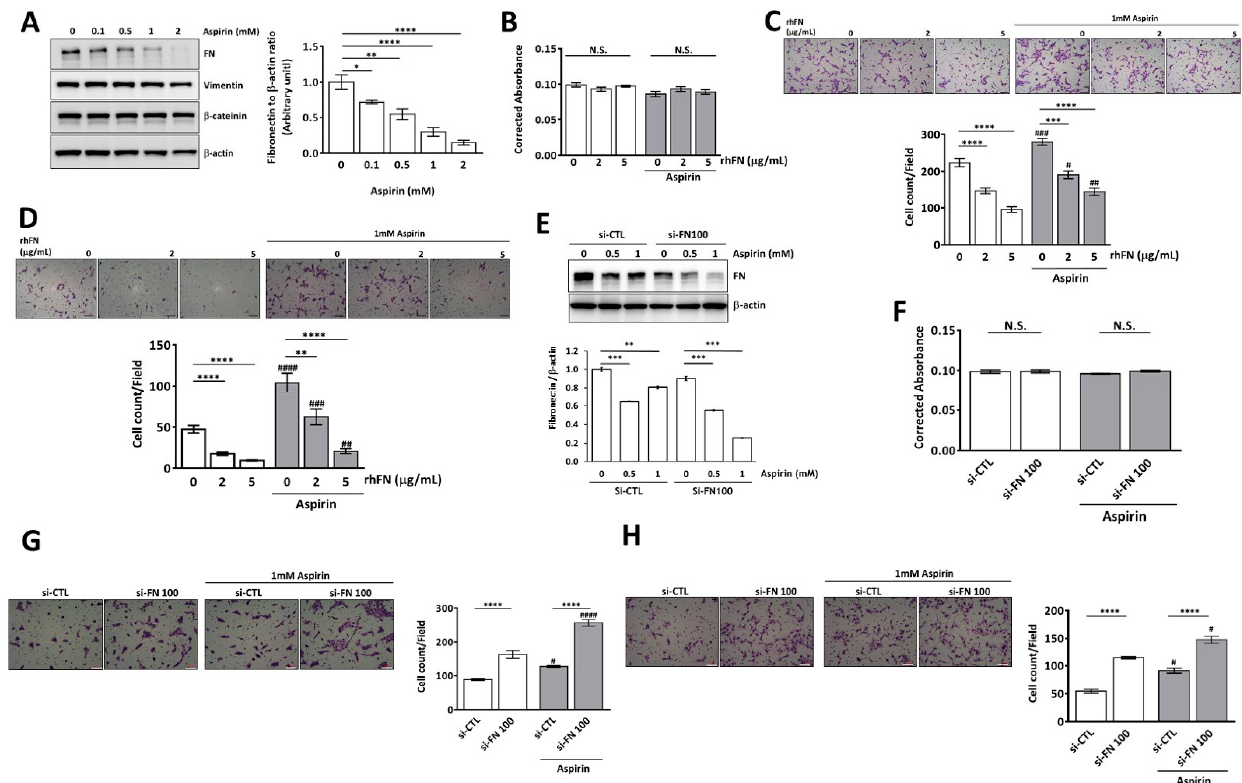
Figure 4. Aspirin inhibits fibronectin (FN) expression and reverses FN-mediated trophoblast migration and invasion in HTR-8/SVneo cells. ( A ) Different doses of aspirin (0, 0.1, 0.5, 1, and 2 mM) were used to treat HTR-8/SVneo cells for 24 h, and then cellular FN expression in the cell lysate was analyzed and quantified using Western blotting. ( B – D ) HTR-8/SVneo cells were treated with rhFN (5 μ g/mL) for 24 h and then aspirin (1 mM) for another 24 h, and the cells were then subjected to ( B ) cell viability, ( C ) cell migration, and ( D ) cell invasion assays. After FN knockdown of HTR-8/SVneo cells with si-FN (100 nM) for 24 h, cells were treated with aspirin (1 mM) for another 24 h before determining ( E ) cellular FN expression using Western blotting and its quantification, ( F ) cell viability, ( G ) migration, and ( H ) invasion assays. Data are presented as the means ± SEMs. N.S. denotes no significance, * p < 0.05, ** p < 0.01, *** p < 0.005, **** p < 0.001 compared with the control treated with the same reagents. # p < 0.05, ## p < 0.01, ### p < 0.005, #### p < 0.001 compared with the samples at the same rhFN or si-FN concentration without aspirin treatment. Scale bar: 100 µ